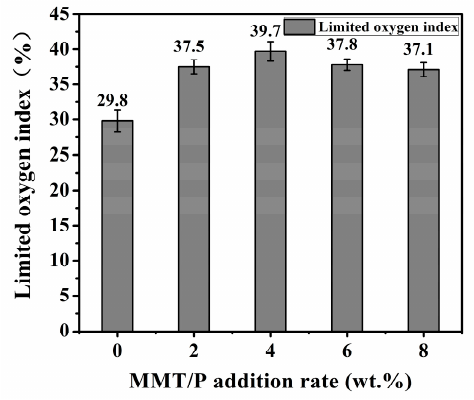
Figure 5. LOI analysis of BPF and MBPFs.